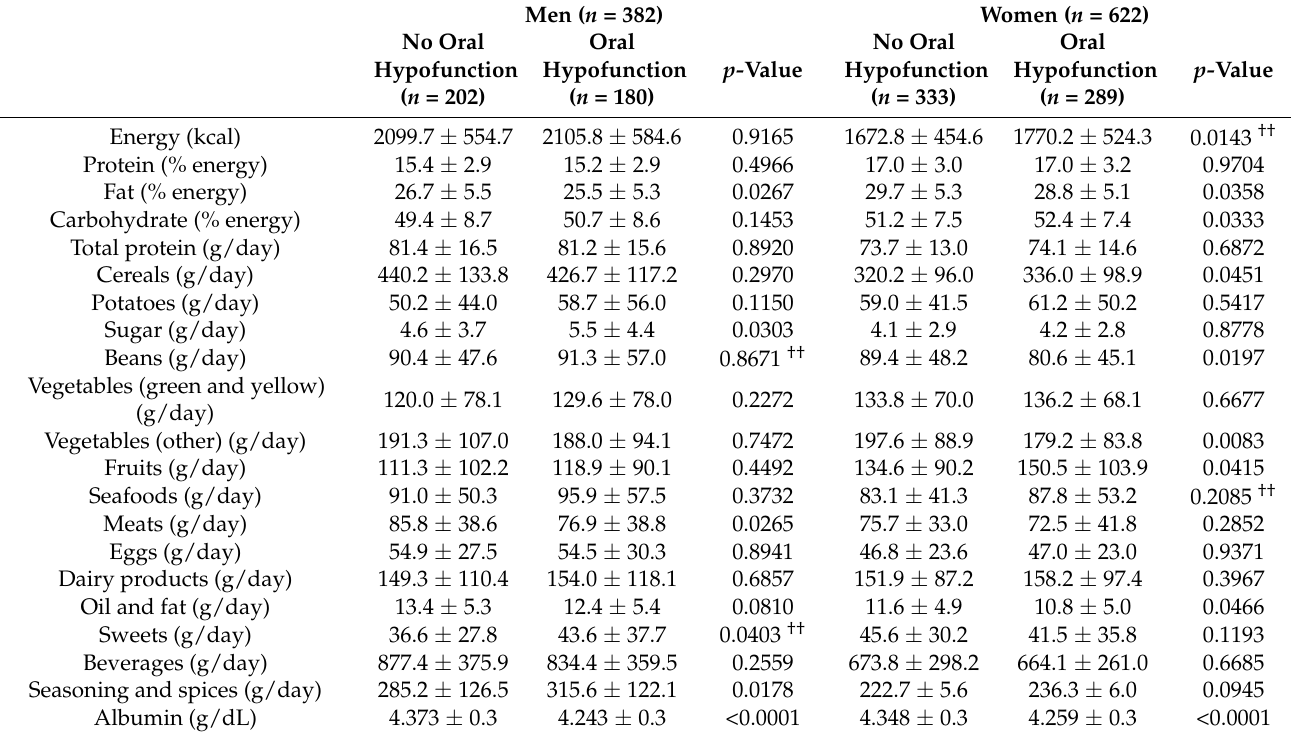
Table 3. Food intake characteristics and albumin serological status in groups with and without oral